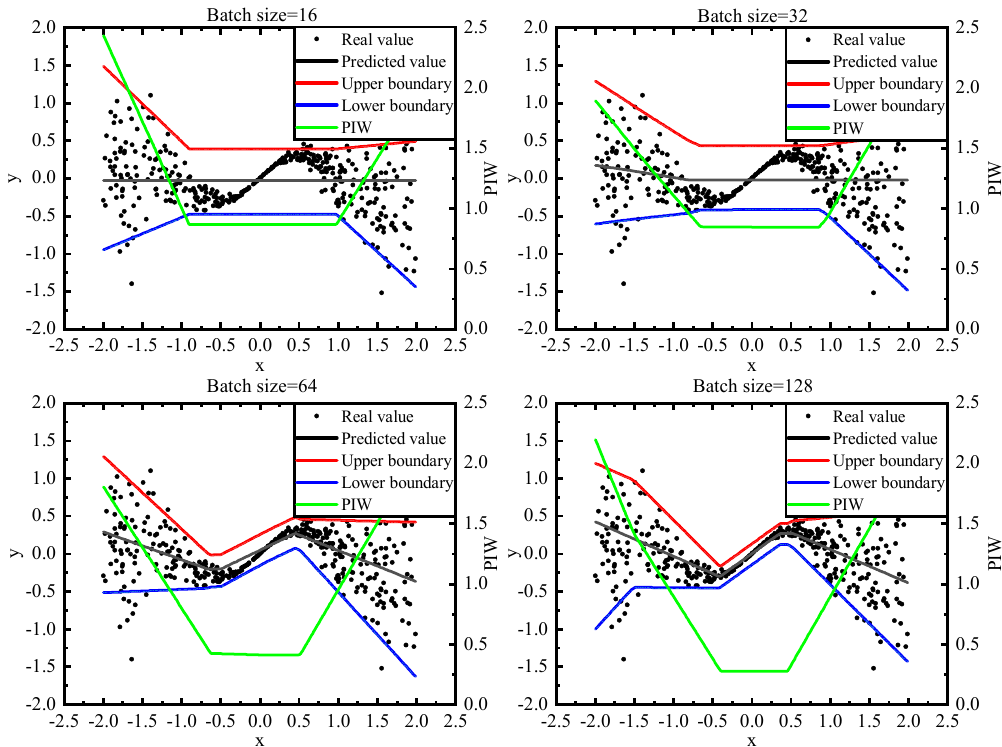
Figure 3. Comparison of PI boundaries for the QD loss by changing the batch size. The upper and lower boundaries are the predicted 95% PIs. The predicted value is generated by the prediction network in the framework.